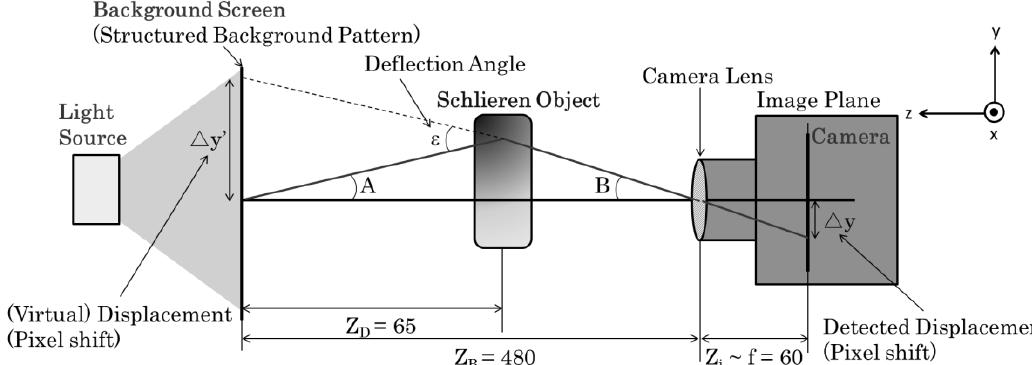
Figure 3. Schematic of background-oriented schlieren (BOS) principle and setup.